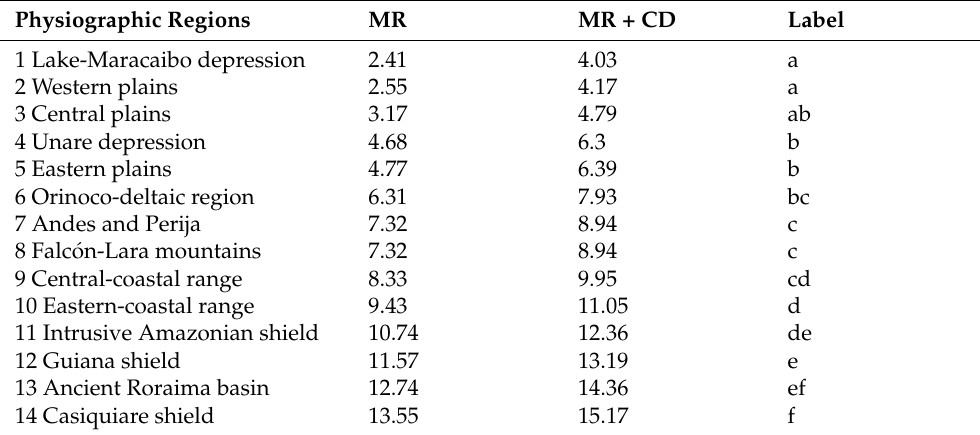
Table 2. Mean ranks (MR) computed by the Nemenyi test to the projected increases in annual mean temperature for the different physiographic